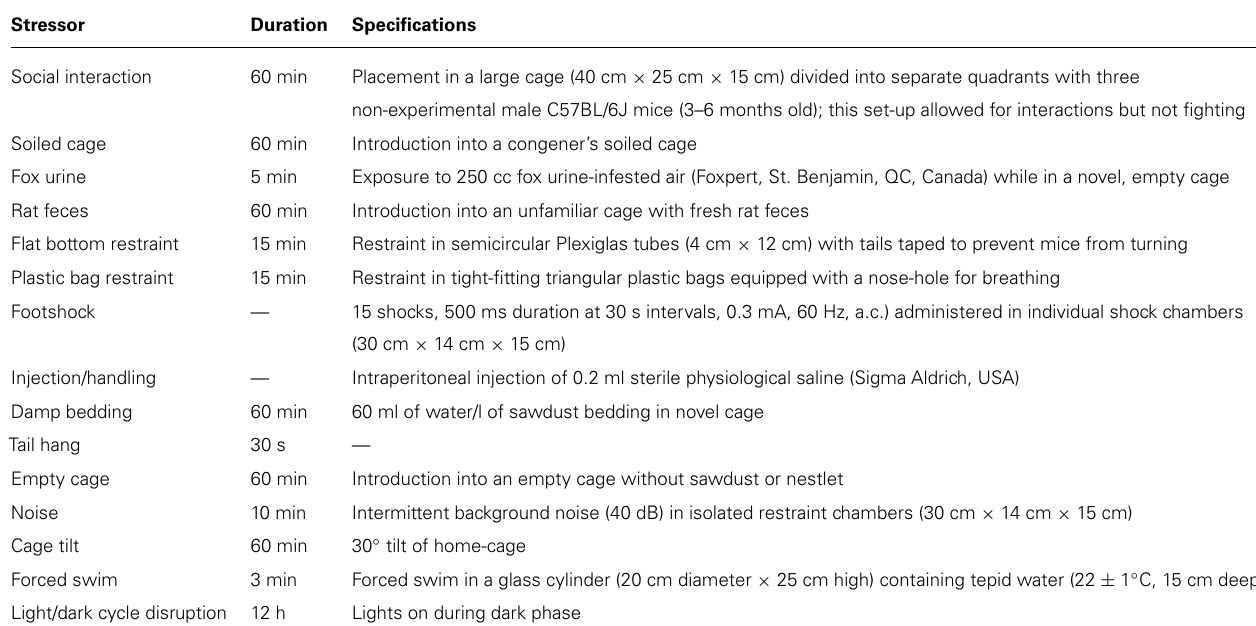
Table 1 | List of